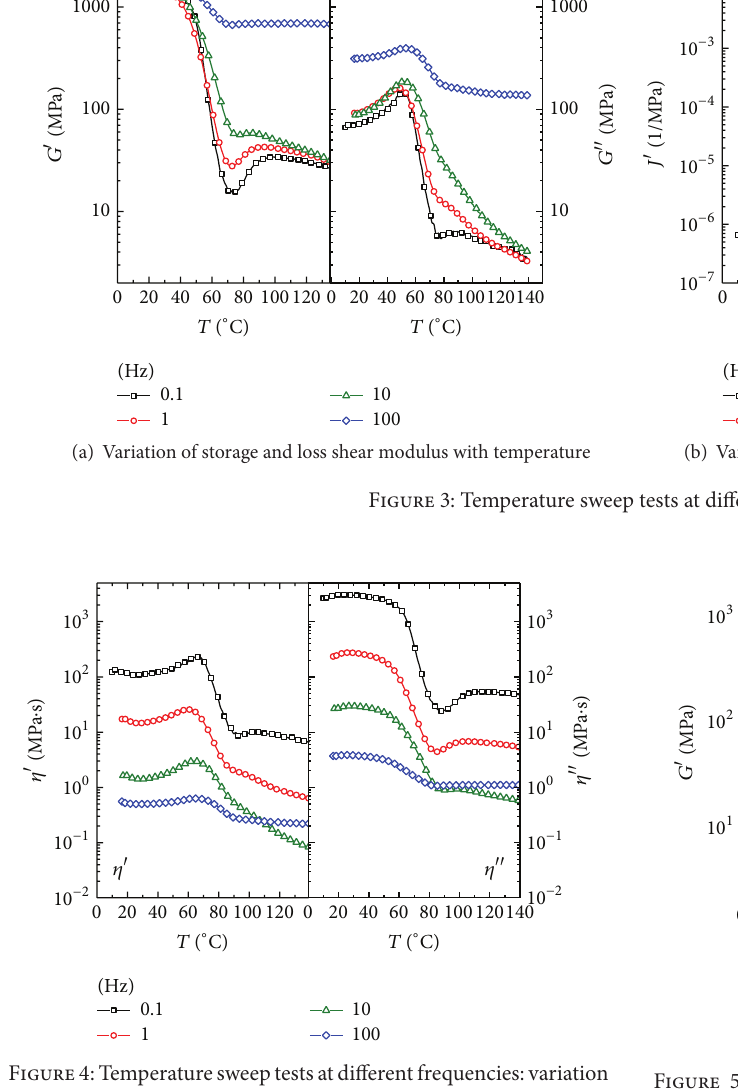
𝜔 from 0.1 to 100 rad ⋅ s −1 . Complementary to this, obtained master curves of 𝐺 󸀠 and 𝐺 󸀠󸀠 are shown in Figure 7(b). Here, ∘ C and 𝐶 𝐶 𝑇 𝑟 is 50 1 and 2 are found to be 8 and 18,